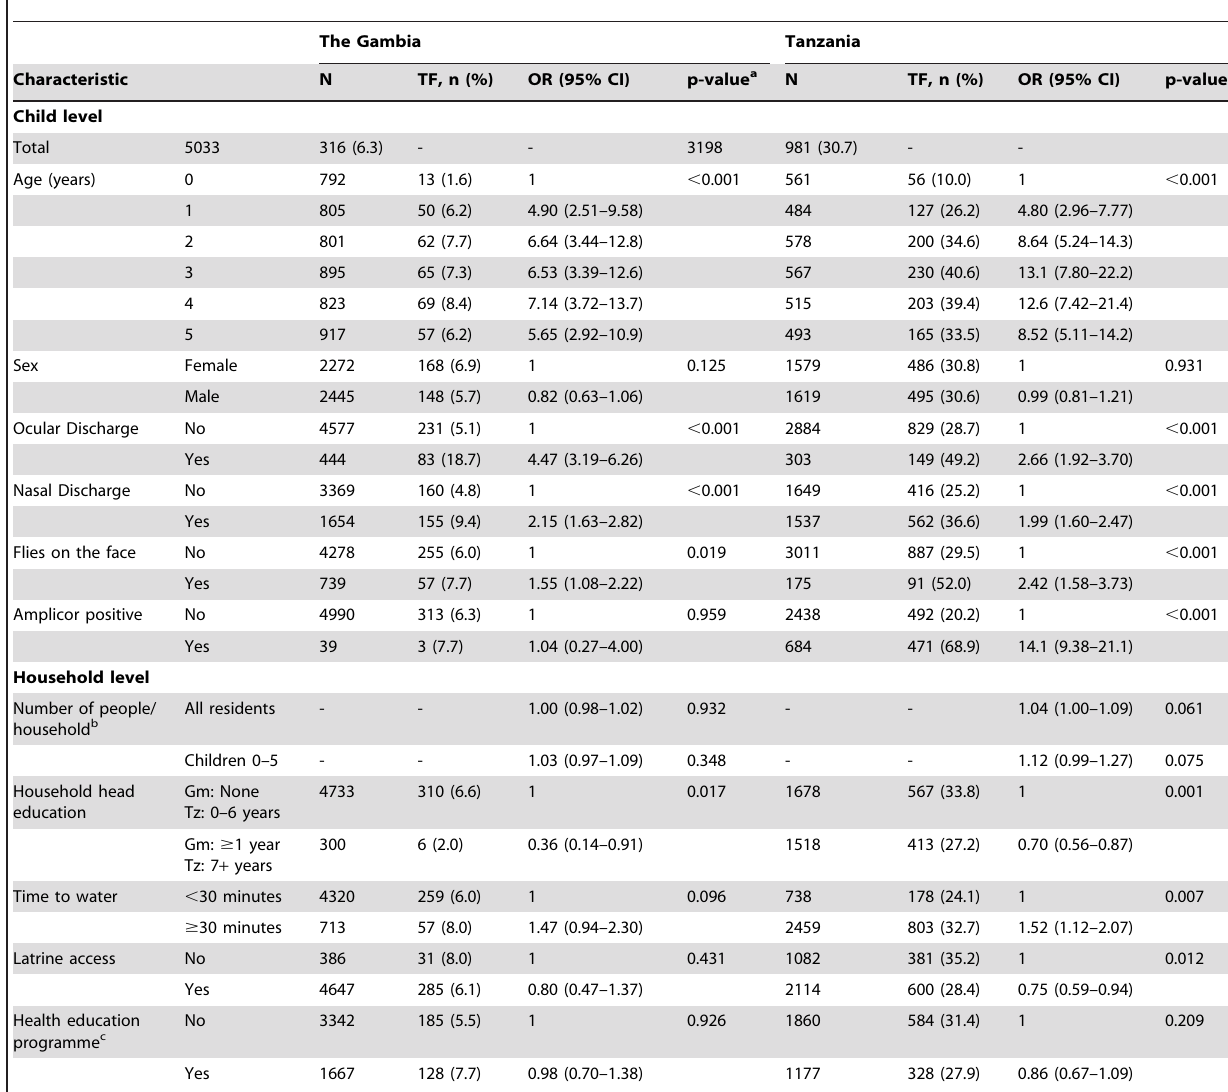
Table 3. Univariate TF risk factor analyses in children aged 0–5 years in The Gambia and Tanzania.